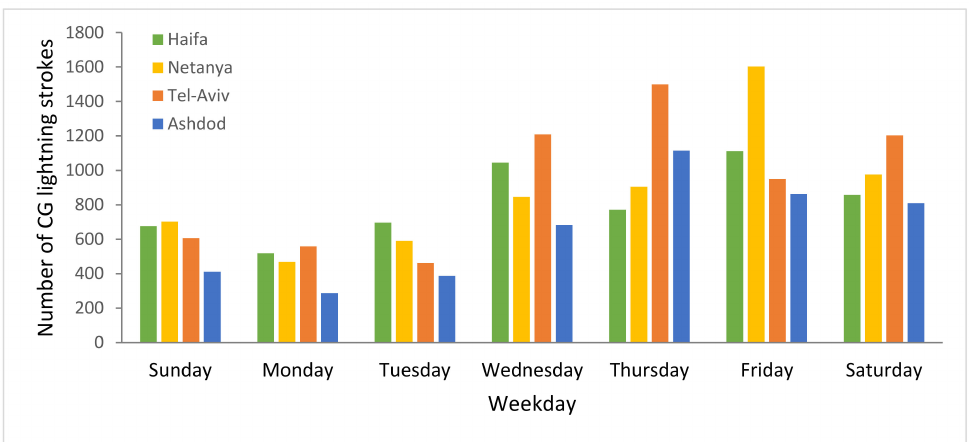
Figure 6. Cloud-to-ground lightning numbers in each day for Tel-Aviv (red), Haifa (green), Natanya (orange) and Ashdod (blue). A conspicuous minimum is observed on Sunday, Monday and Tuesday in all 4